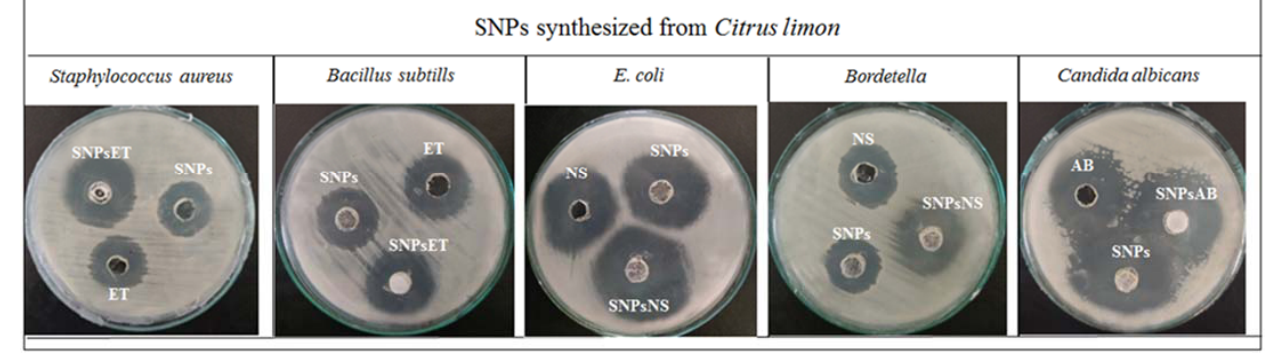
Figure 6. Antimicrobial and antifungal activity of SNPs of Citrus limon extract against different strains.